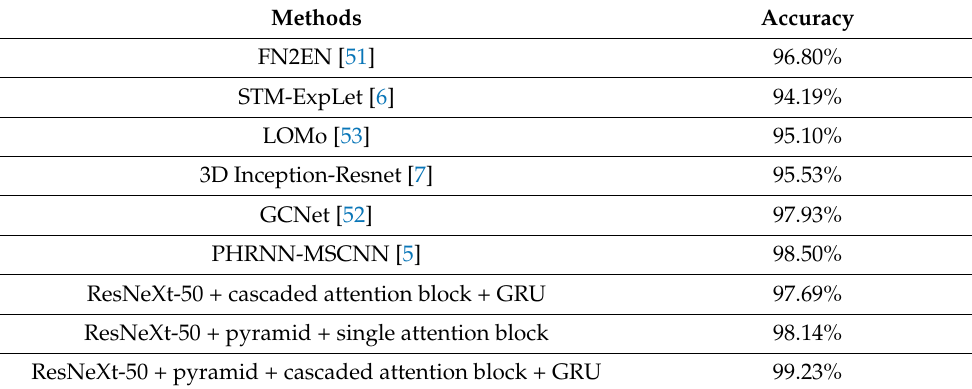
Table 2. Comparison on the CK+ dataset.